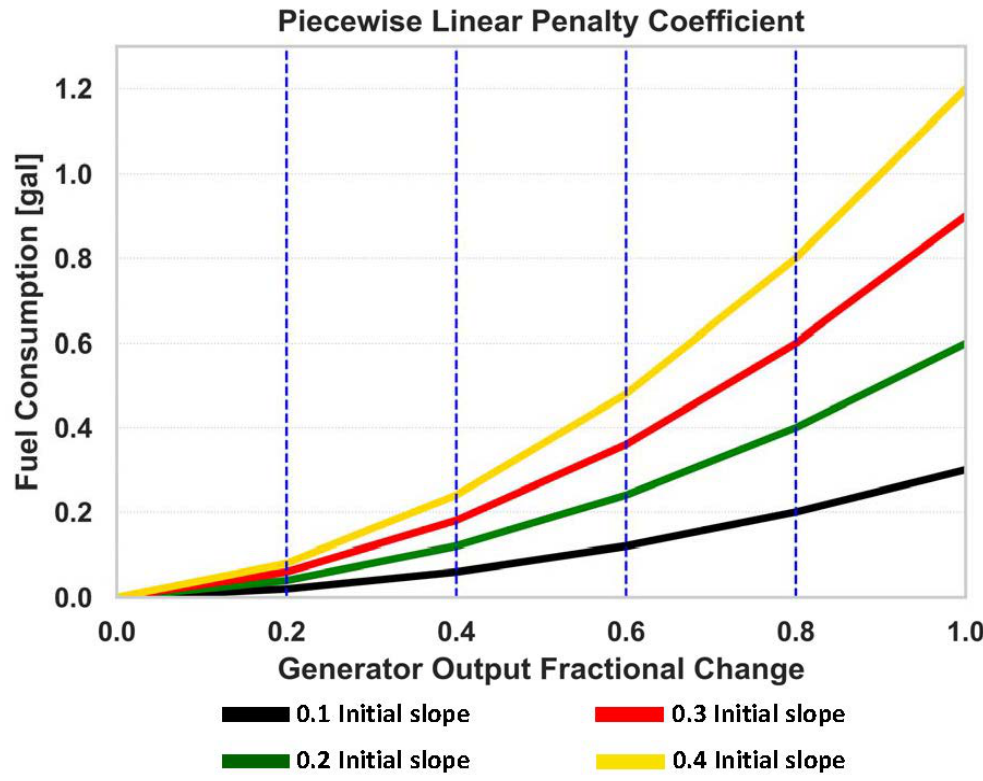
Figure 5. Fuel consumption plots for piecewise linear penalty profiles with varying initial